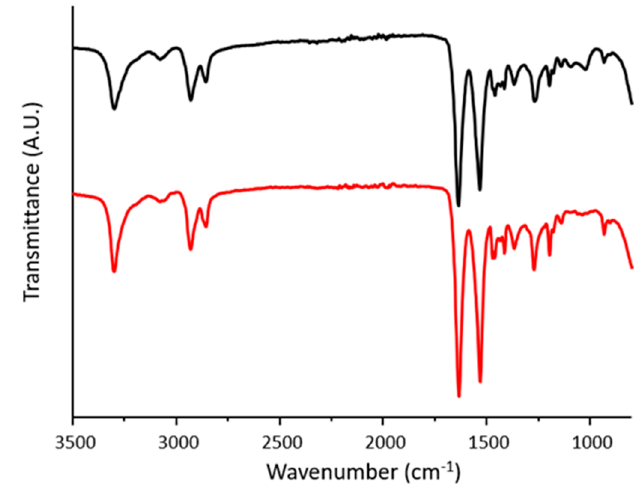
Figure 7. ATR analysis of NYL + TiO 2 + AuPd samples: fresh (black, up) and used (red, bottom).